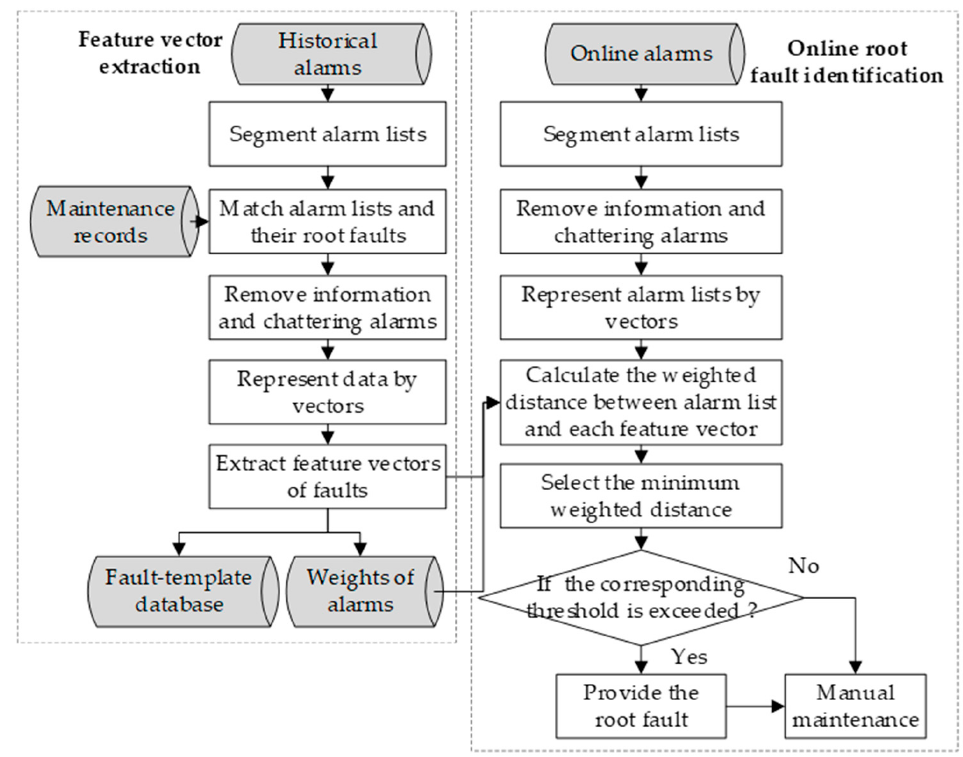
Figure 1. The flowchart of the proposed online root faults identification method.